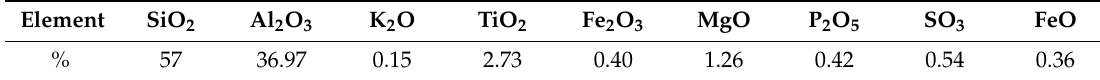
Table 1. Elemental composition of metakaolin.